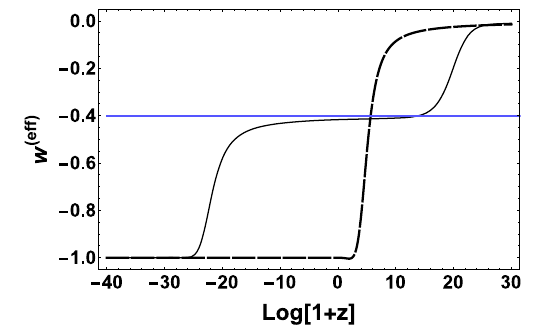
Fig. 2 The effective equation of state for two different cosmological solutions with de Sitter phase for models with g ( R ) = R log [ α R ] and h ( − T ) = c 2 exp [− c 1 ( − T ) − β( − T ) 4 / 12 ] . The dashed curve shows a direct transition from matter era to de Sitter phase. The full curve indicates an intermediate P 6 solution